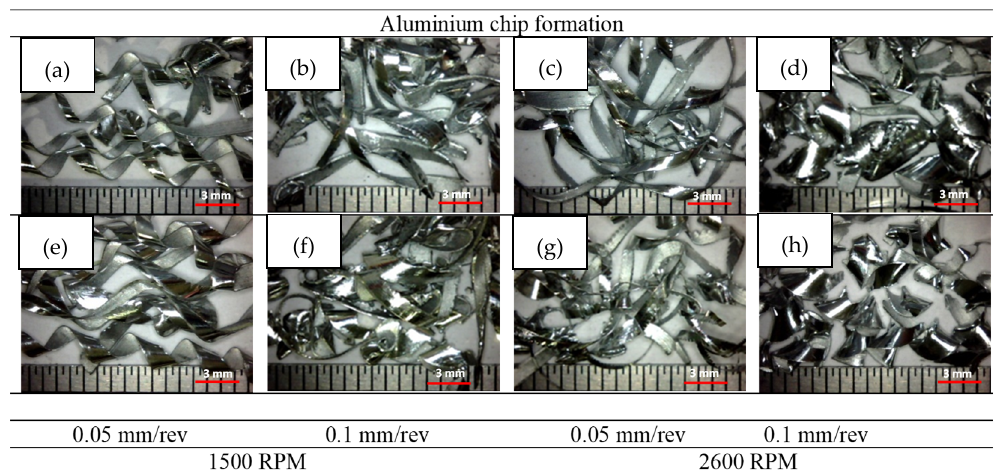
Figure 12. Chip characteristics of AA7075-T6 depending on tool geometry parameters and cutting parameters: ( a – d ) Point angle of 110°, ( e – h ) Point angle of 130° [95].